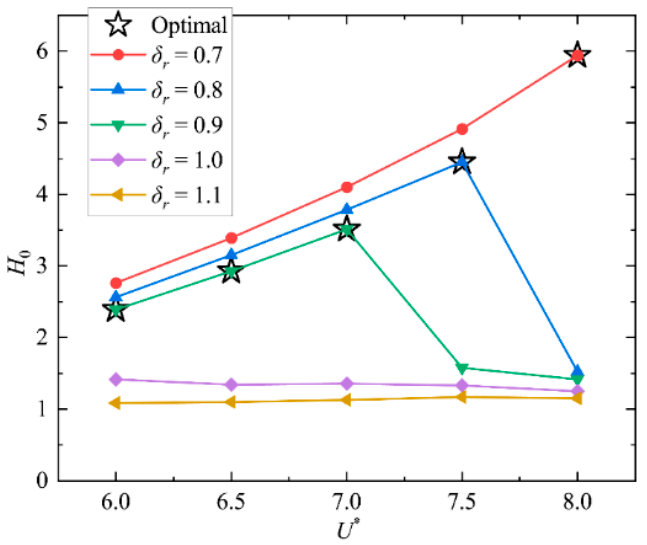
Figure 14. Variations of the oscillating amplitude with the reduced speed and mass-damping parameters.